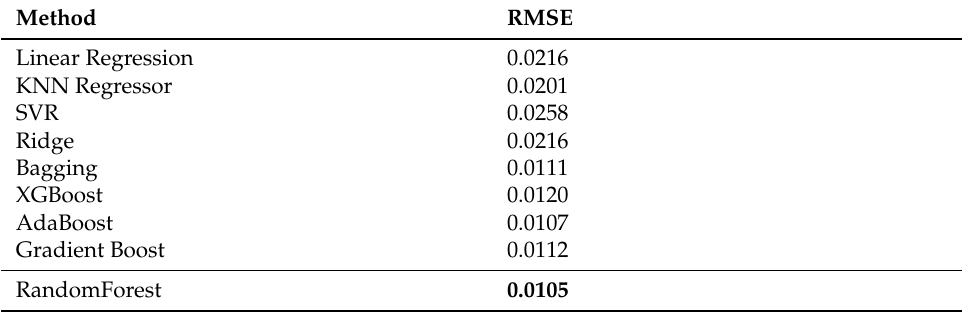
Table 8. RMSE results of different surrogate models on the test samples